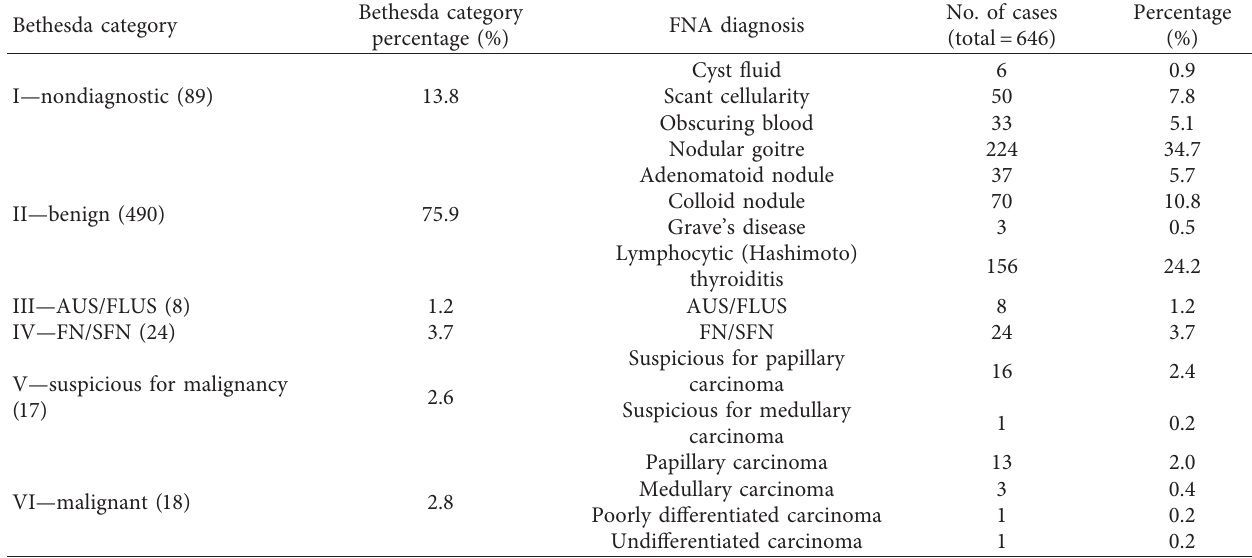
Table 1: Distribution of cases according to the Bethesda